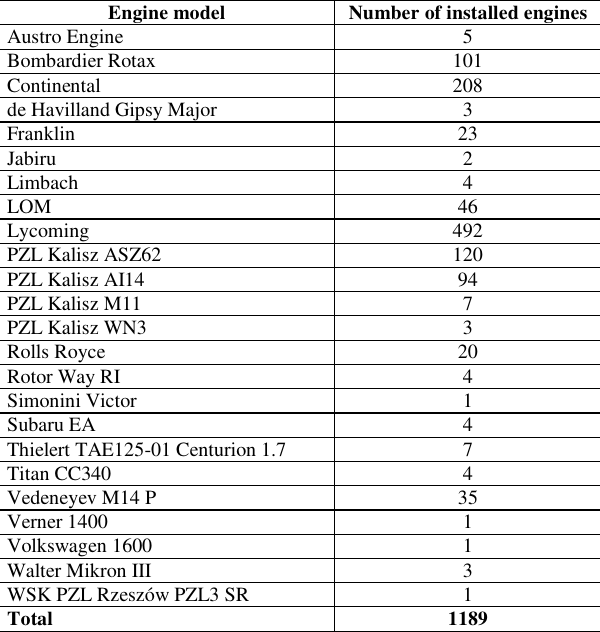
Table 4. Model and number of the piston engines Engine model